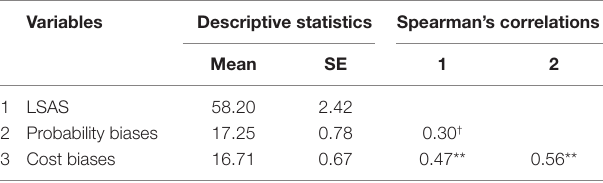
TaBle 2 | relations between social anxiety symptoms and cognitive biases of probability and costs of negative evaluation. Variables